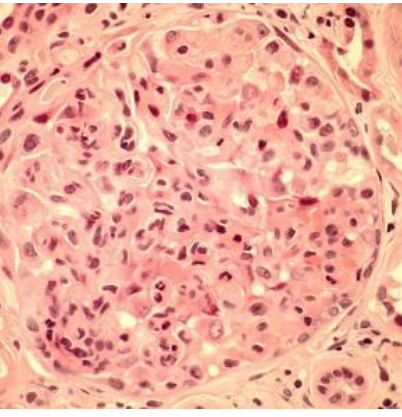
FIGURE 1 . H&E stain: endocapillary hypercellularity with neutrophil